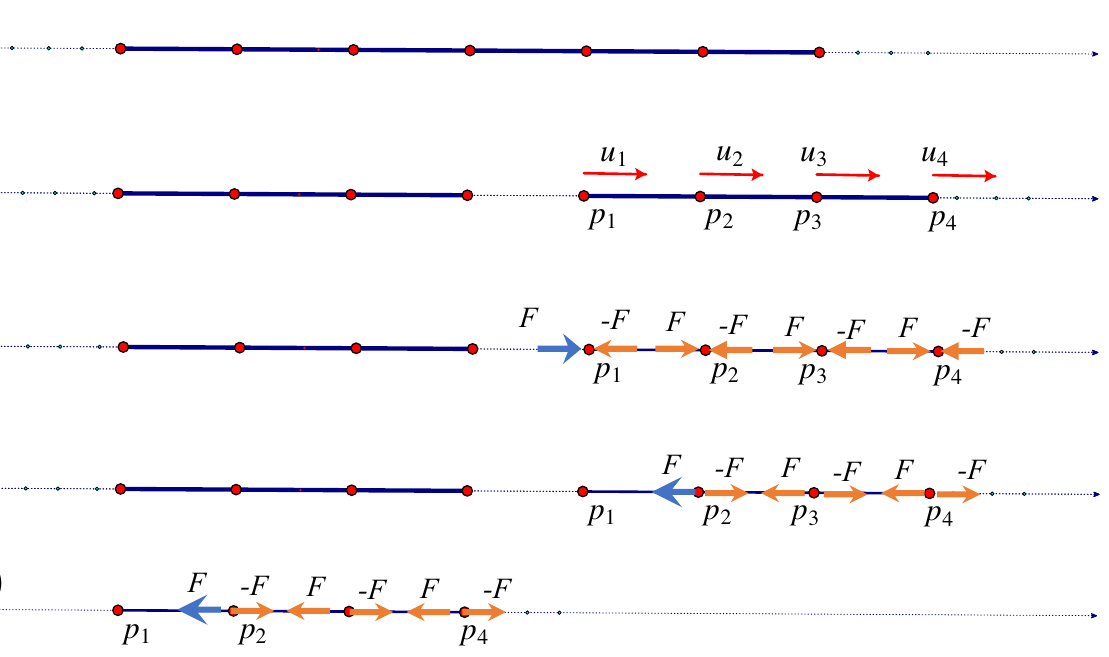
Figure 8. ( a ) shows a connected infinite framework which is infinitesimally and statically rigid on the line. ( b ) shows a disconnected framework which is not infinitesimally rigid. ( c , d ) show resolutions of forces applied to this disconnected framework. ( e ) shows a one direction infinite framework with the resolution of